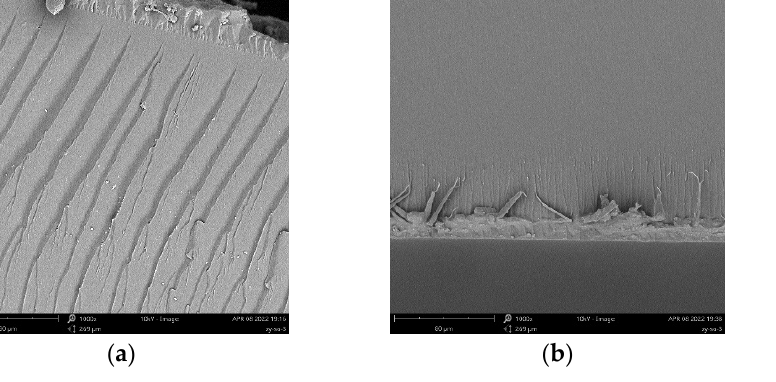
Figure 3. Scanning electron microscopy (SEM) images of ( a ) free radical − cationic/hybrid, ( b ) polyurethane acrylates (20%) modified, and ( c ) graphene oxide (0.7%) modified photosensitive resins in 1000× magnification.